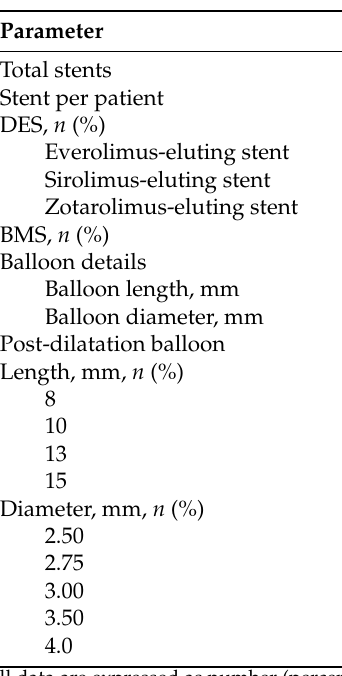
Table 3. Stent, pre-dilatation and post-dilatation balloon specifications.